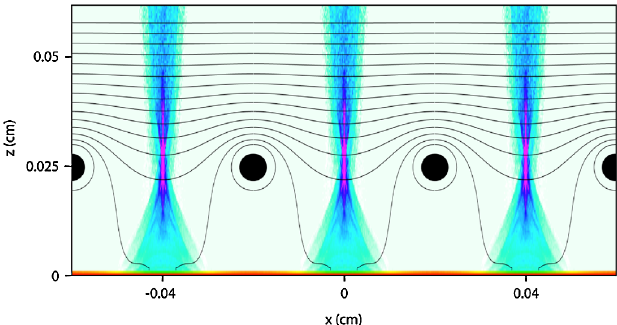
FIG. 8. TURBOWAVE simulations of the cathode-grid region including the effects of space-charge. The simulation geometry is 2D Cartesian slab. The color scale indicates time-averaged current density, with red more dense and blue less dense. The cross sections of four grid wires are shown. The peak current density between the wires is 150 A = cm 2 . The total charge associated with a single beamlet is 45 pC = cm . The cathode is located at z ¼ 0 , the lower boundary of the figure. Parameters are the same as in Fig. 6. Black curves show the equipotentials.